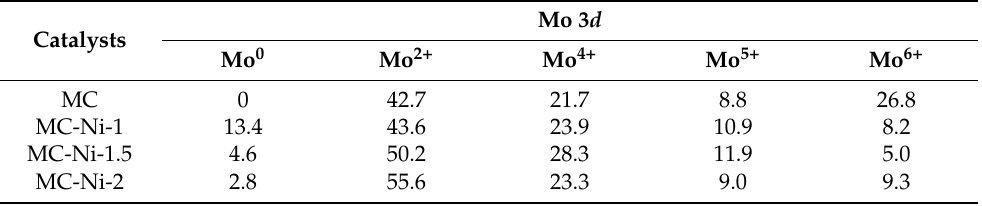
Table 4. The percentage content of Mo species calculated from the XPS